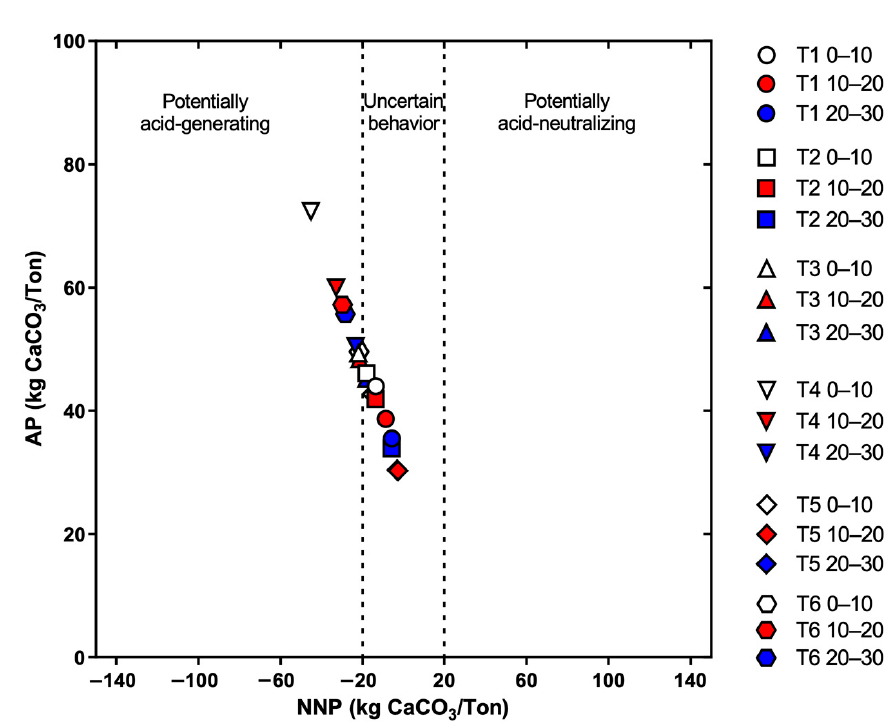
Figure 5. Results of the ABA test. AP and NNP are expressed in kg CaCO 3 /ton. For interpretation, vertical lines in NNP at − 20 and +20 kg CaCO 3 /ton are shown.